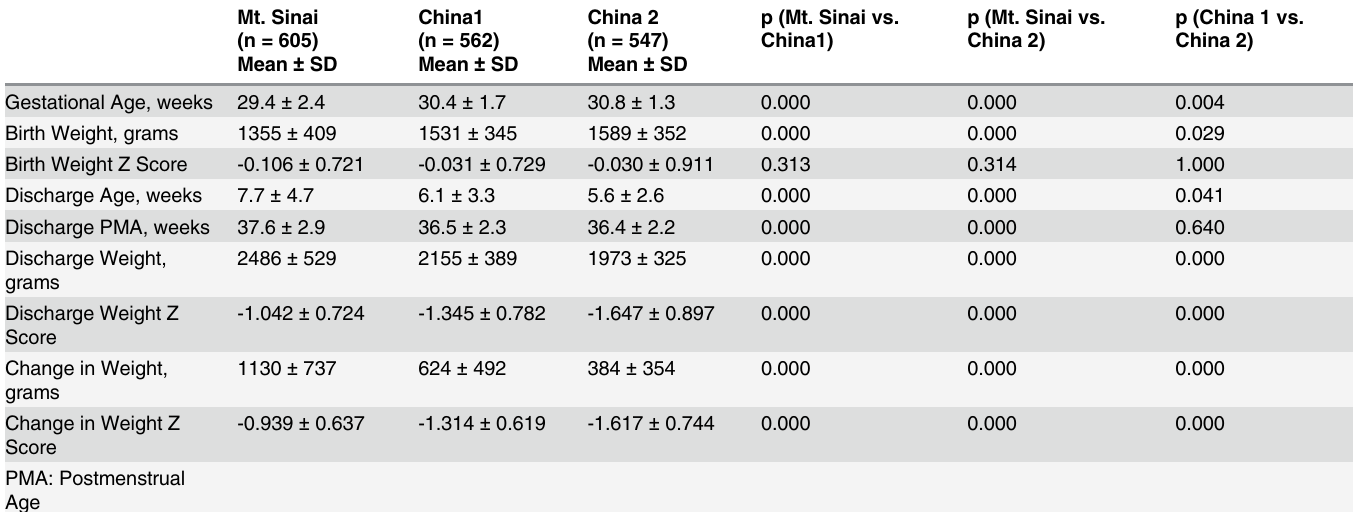
Table 1. The basic demographic characteristics of the three groups at birth and at discharge.